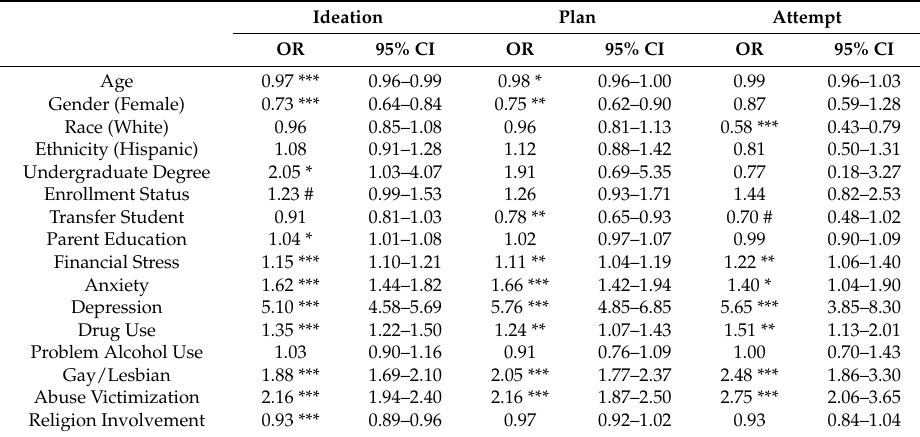
Table 3. Summary of three logistic regression models with suicidal behaviors as outcomes.